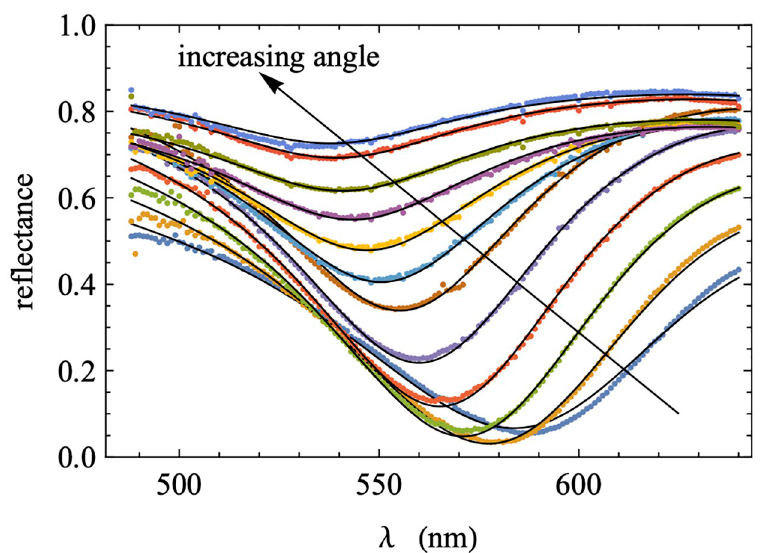
Fig 5. ATR reflectance as a function of excitation wavelength shown for a range of internal angles (50 to 61 degrees in one-degree increments). Shown are experimental measurements (symbols) together with model results (lines) for corresponding internal